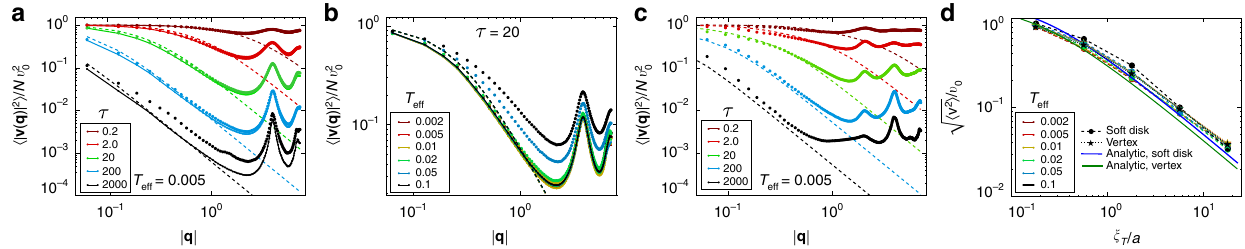
Fig. 3 Behaviour of velocity correlation functions. a Velocity correlations in Fourier space for the soft disk model for different τ at T eff = 0.005 in the glassy phase and b : for changing T eff at τ = 20. Dots correspond to the simulated velocity correlation function, solid lines are the results from the normal mode expansion Eq. (6), and the dashed lines are the continuum elasticity predictions Eq. (10). c Fourier velocity correlations for the SPV model, together with analytical prediction. d Mean-square velocity as a function of ξ T ∕ a for both soft disks and the SPV model and analytical predictions (solid lines). All = τ , and there are no fi t parameters in the correlation functions have been normalized by v 2 2 T 0 ¼ eff